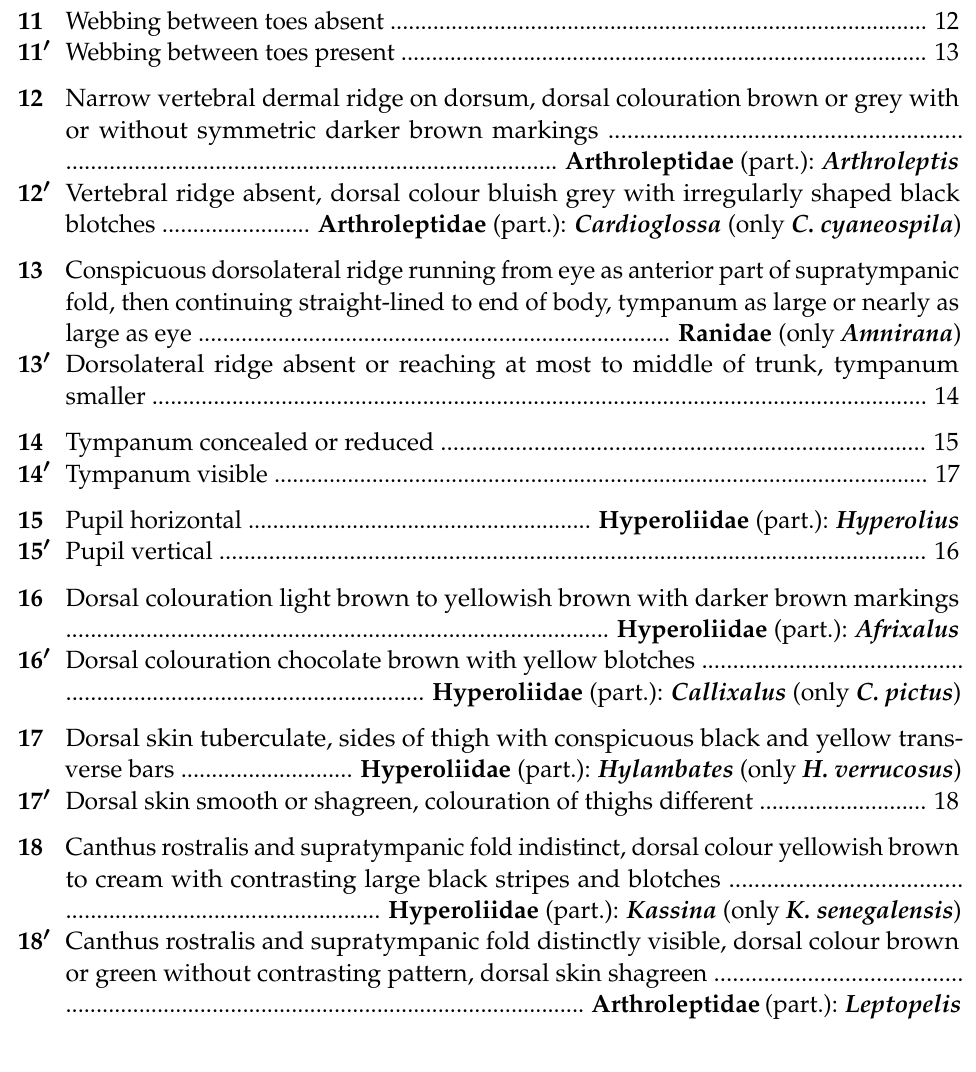
10 (cid:48) Dorsolateral ridge absent or extending from supratympanic fold .......................... 11